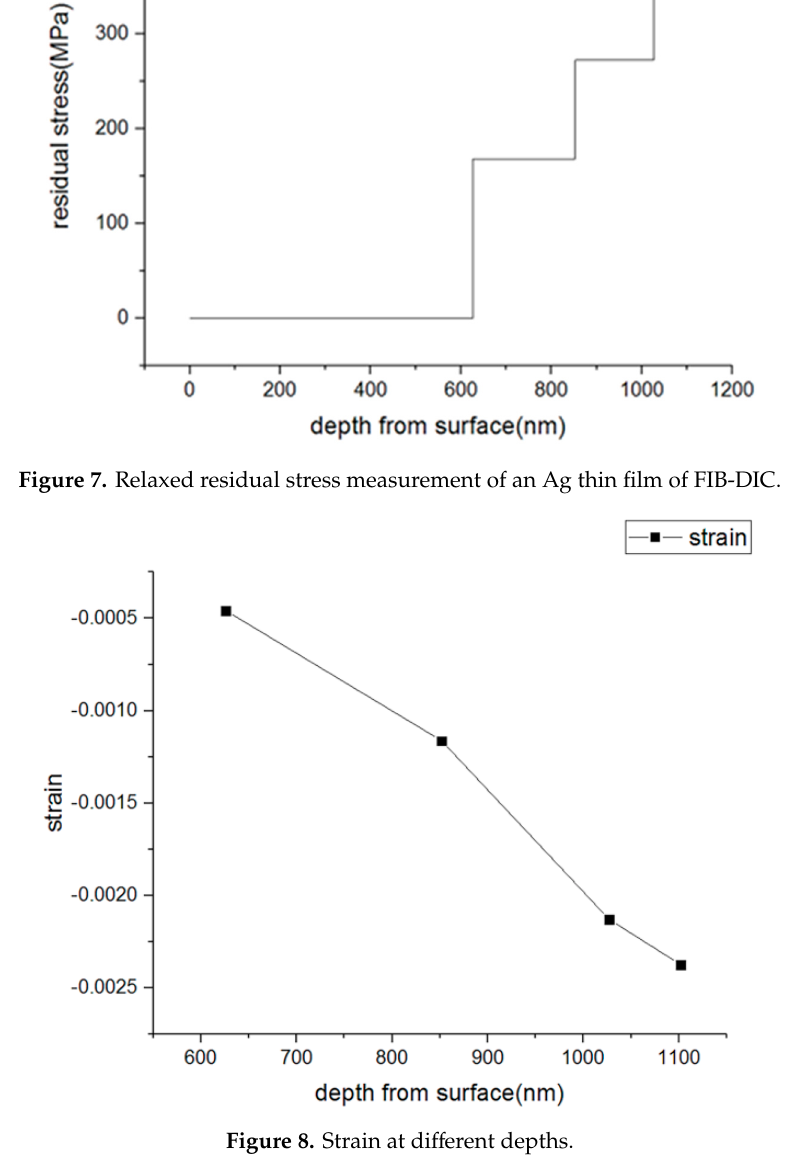
Table 4. The residual stress measurement results of Ag thin films compared with the values obtained from other literatures.